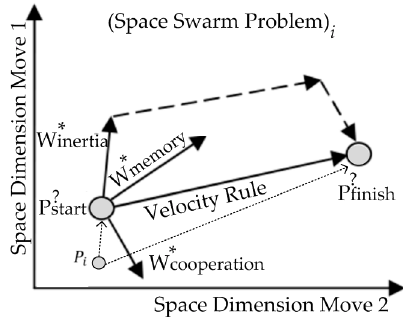
Figure 2. Brief illustration of DEEPSO (differential evolutionary particle swarm optimization) particle movement rule.